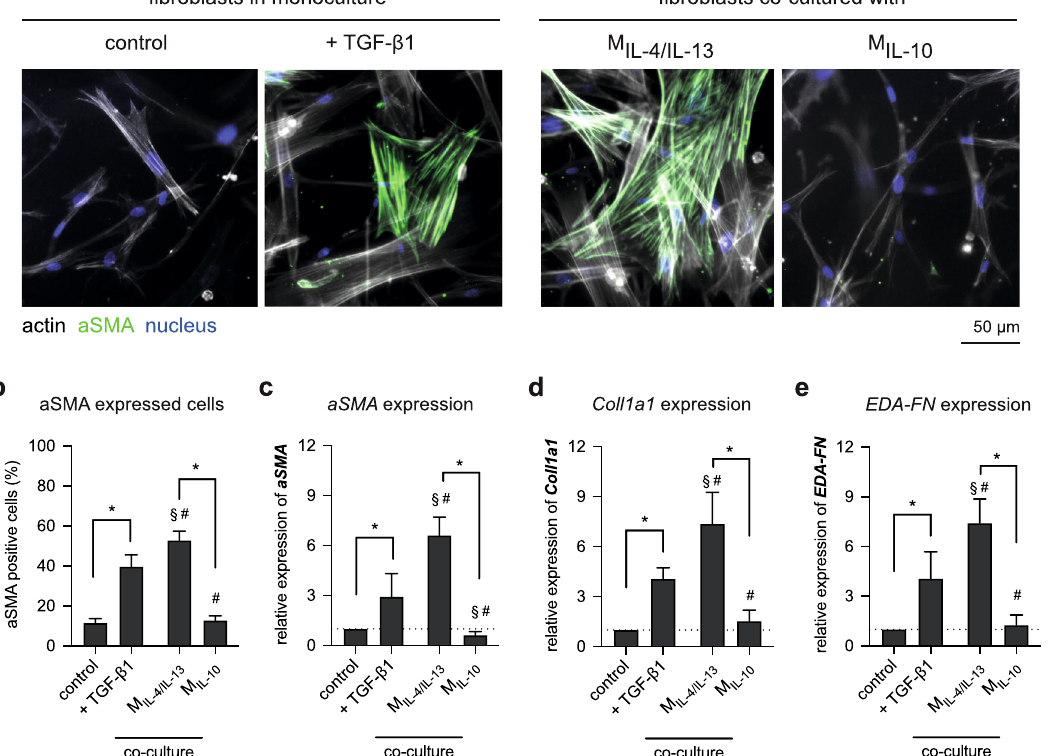
Fig. 4 Alteration of fi broblast morphology and speci fi c markers in the presence of TGF- β 1 and co-culture with M2 macrophages subtypes. a Representative images showing nuclei (blue), actin fi laments (gray), and α SMA (green) (scale bar: 50 μ m). Fibroblast differentiation was analyzed by b manual counting of α SMA-positive cells. At least 200 cells per condition were counted. Gene expression analysis of c α SMA , d Coll1a1 , and e EDA-FN were performed using qPCR. Data are represented as mean ± SD; *a signi fi cance level of p ≤ 0.05 using a one-way ANOVA followed by Tukey ’ s post hoc analysis. The characters # and § represent the signi fi cance level of p ≤ 0.05 using a one-way ANOVA followed by Tukey ’ s post hoc analysis when compared to control, and treated samples with TGF- β 1, respectively. Experiments were performed in four